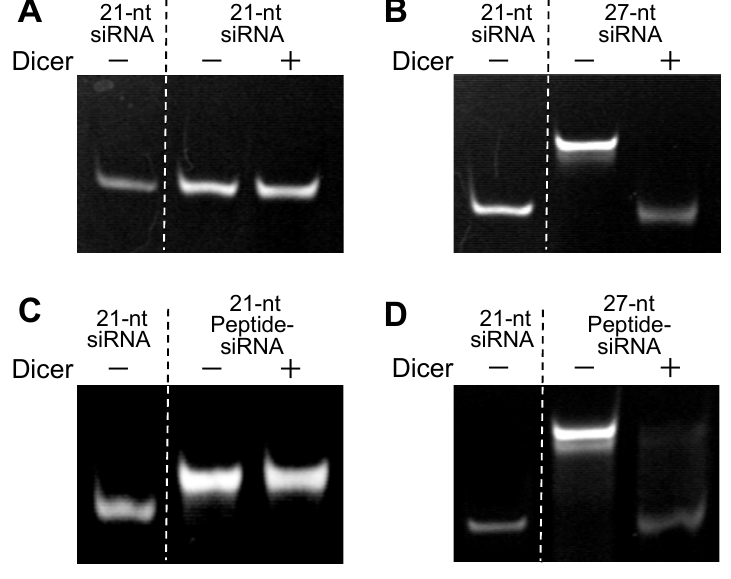
Figure 2. Dicer-substrate siRNAs including peptide conjugates. 21-nt siRNA ( A ), 27-nt siRNA ( B ), 21-nt Peptide-siRNA ( C ), and 27-nt Peptide-siRNA ( D ) were reacted with the recombinant Dicer enzyme for 12 h at 37 °C. The reaction products were electrophoresed on 20% PAGE and visualized by silver